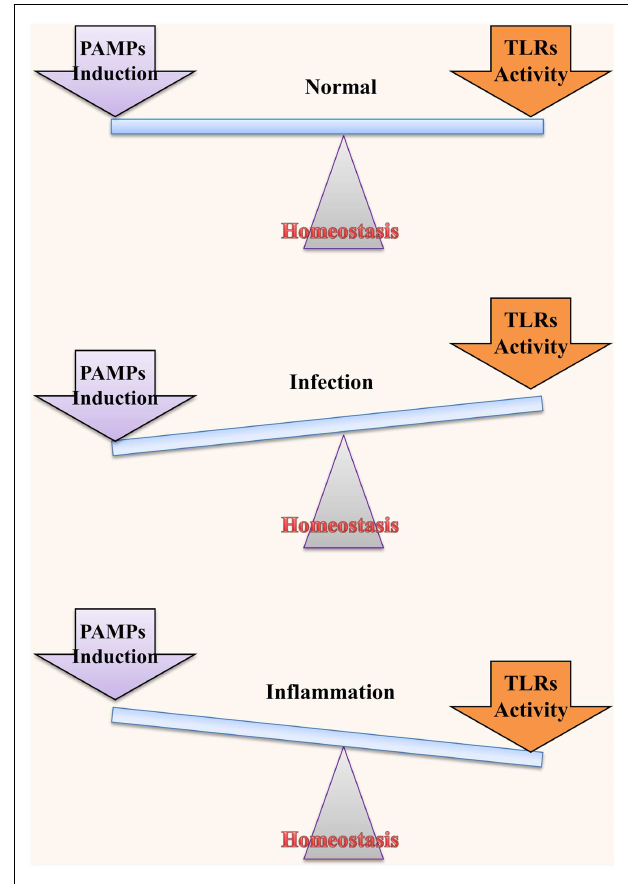
FIGURE 2 | Homeostatic interaction between microbiota andTLRs . TLRs play an important role in maintaining normal functions of IECs; however, regulation of the activation and induction ofTLRs through various mechanisms is necessary for this role.TLRs in the intestine exist in close proximity to and may be stimulated by commensal bacteria.Therefore, it is extremely necessary to regulate their functions. Under normal conditions, homeostasis between bacterial induction andTLR activation is maintained to ensure a disease-free status. On the other hand, ifTLRs are inappropriately activated or if they mount an exaggerated immune response to a low level stimulus, they may culminate in bacterial infection and inflammatory disease/cancer,